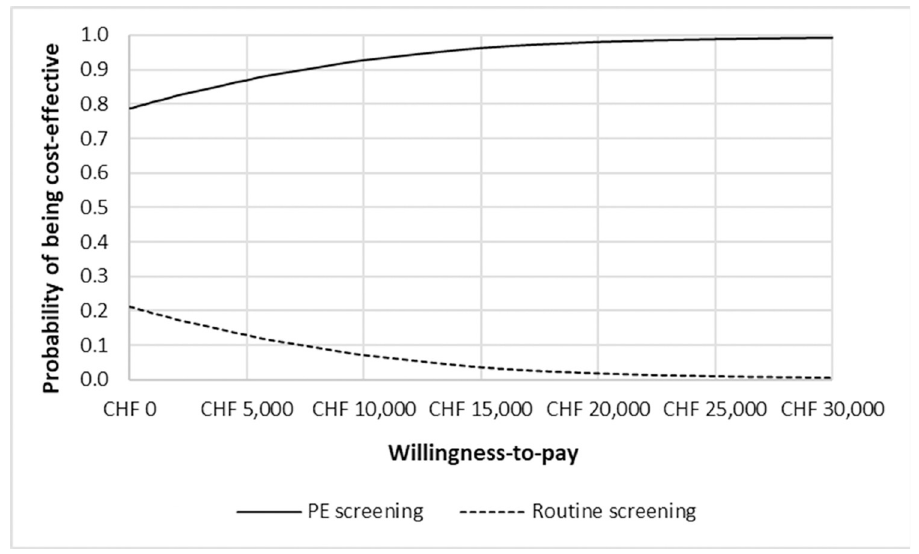
Fig 7. Cost-effectiveness acceptability curve for